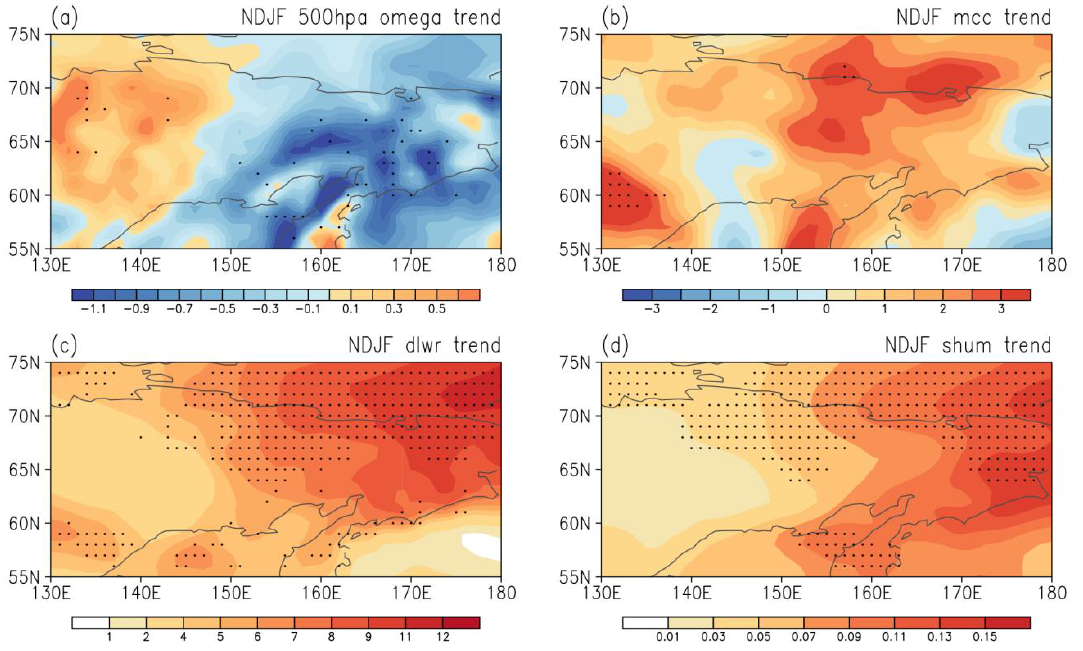
Figure 6. Linear trends of NDJF ( a ) omega at 500 hPa (Pa hour −1 10a −1 ), ( b ) middle cloud cover (mcc, % 10a −1 ), ( c ) downward longwave radiation (dlwr, W m −2 10a −1 ), ( d ) average specific humidity from 1000 hPa to 700 hPa (shum, g kg −1 10a −1 ) for the period 2000 – 2019. Dotted regions denote trends significant at the 95% confidence level.